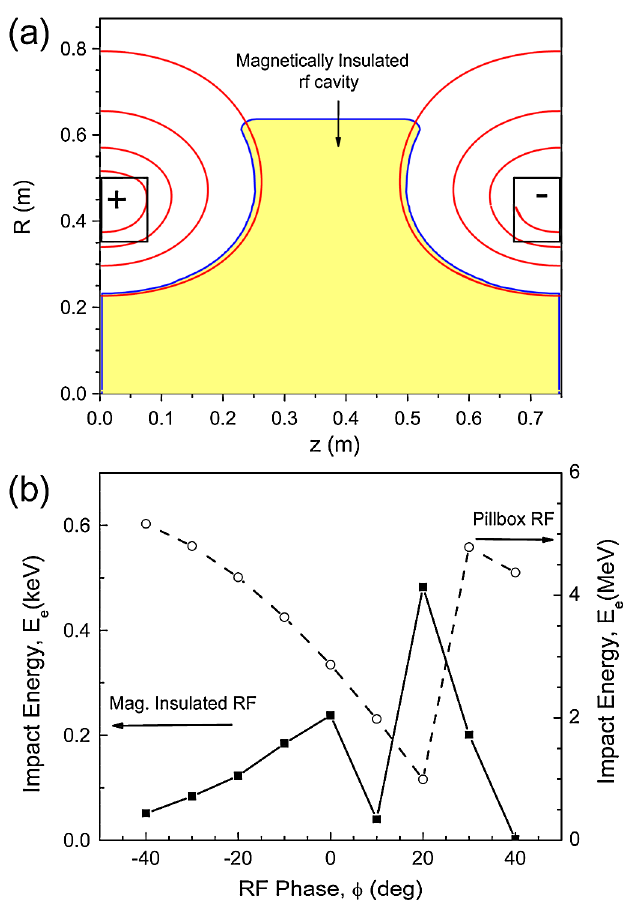
FIG. 3. The principle of rf magnetic insulation: (a) schematic layout of a magnetically insulated 201 MHz cavity for a neutrino factory; (b) the energies of the returning electrons as a function of the rf phase when they are emitted. The solid line shows the energies for a magnetically insulated cavity, while the dashed line shows the energies for a conventional pillbox